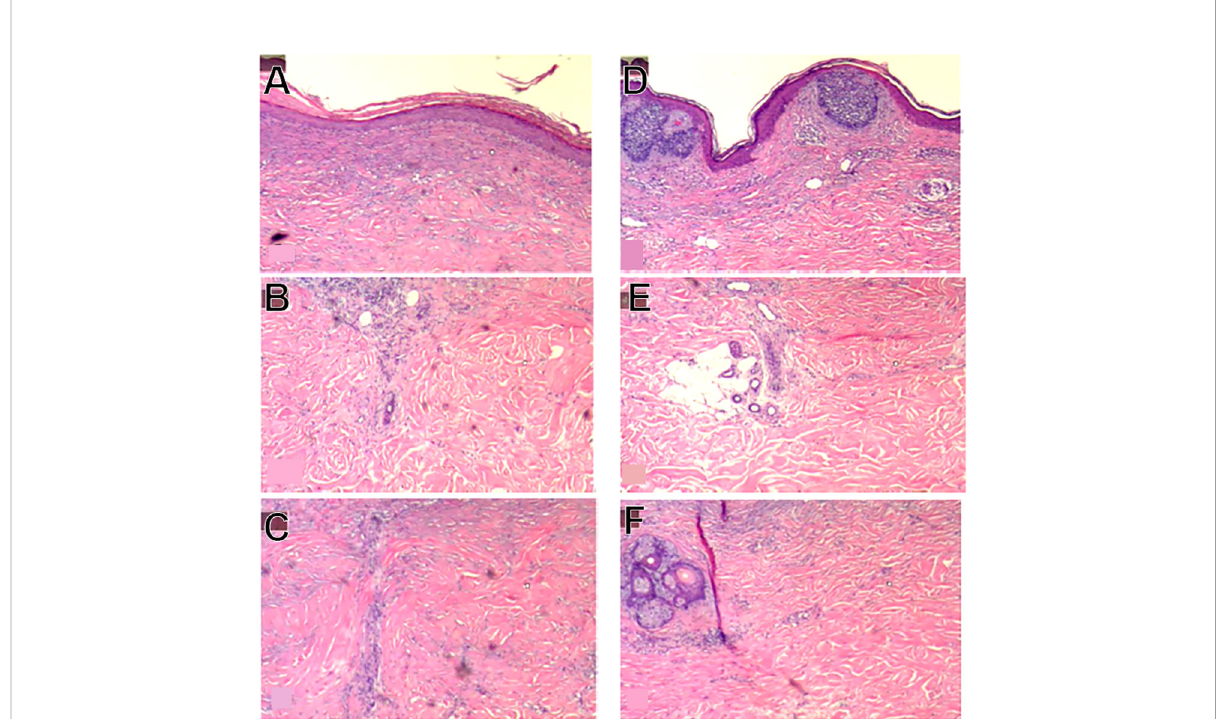
FIGURE 3 Example of identi fi ed treatment zone (A-C) and area with residual BCC (D-F) . (A) shows fl attening of the epidermal/dermal junction and mild dermal fi brosis compared to (D) . (B) shows a sweat duct under the clear treatment zone where the majority of the adnexal structure is destroyed, compared to (E) where the sweat duct is located beneath the residual BCC and is completely intact. (C) shows presence of thicker collagen in the clear treatment zone where thicker collagen is not observed in (F)